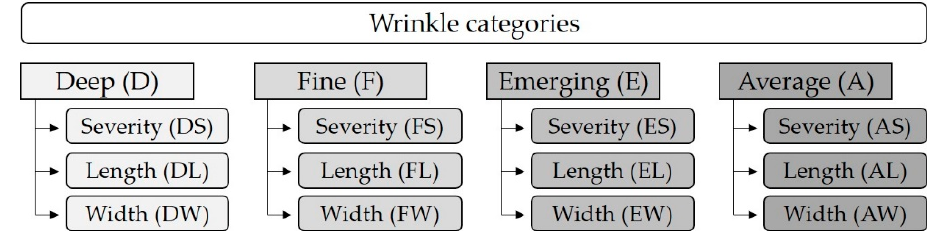
Figure 1. Classification of wrinkles. Deep wrinkles are high contrast, fine wrinkles are medium contrast, and emerging wrinkles are low contrast lines. Average wrinkles are the mean of all three categories. Severity is calculated as contrast multiplied by length.